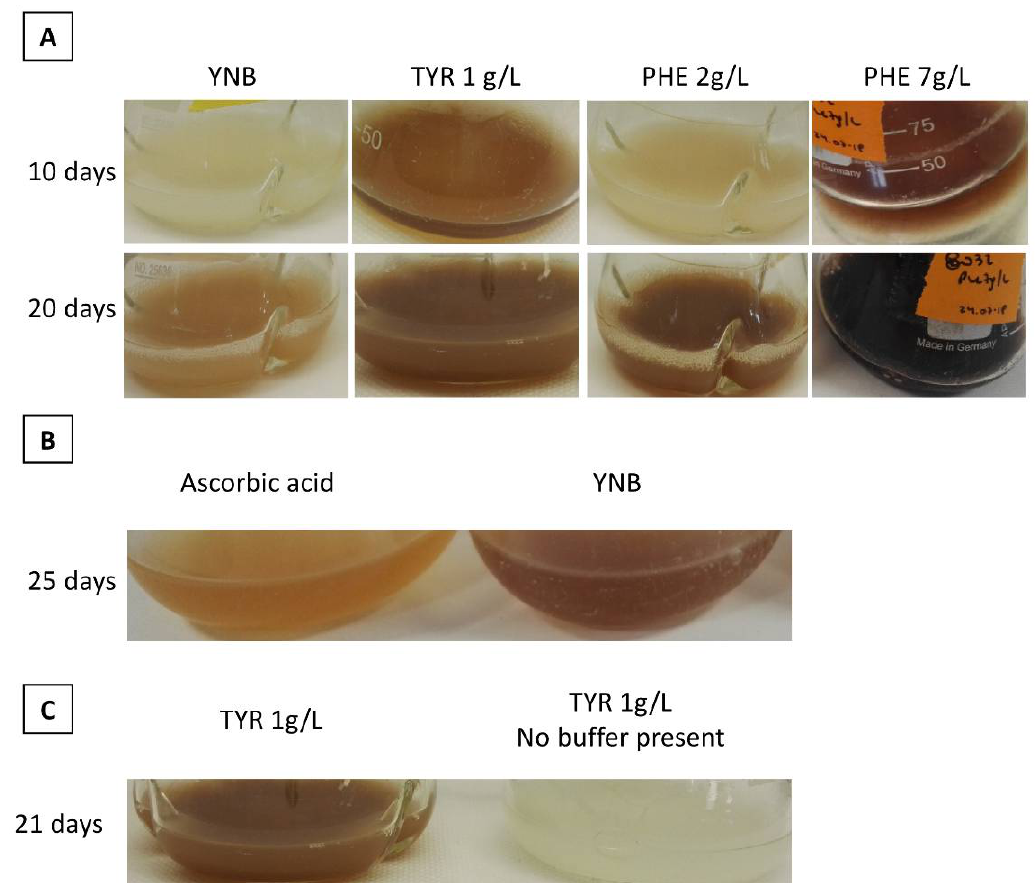
Figure 3. ( A ) Changes in pigment levels over time and in response to tyrosine (TYR) or phenylalanine (PHE) supplementation. ( B ) Inhibitory effect of ascorbic acid on pigment production. ( C ) Inhibitory effect of low pH on pigment production, due to the absence of buffer in the medium. All cultures were performed using the strain JMY8032.